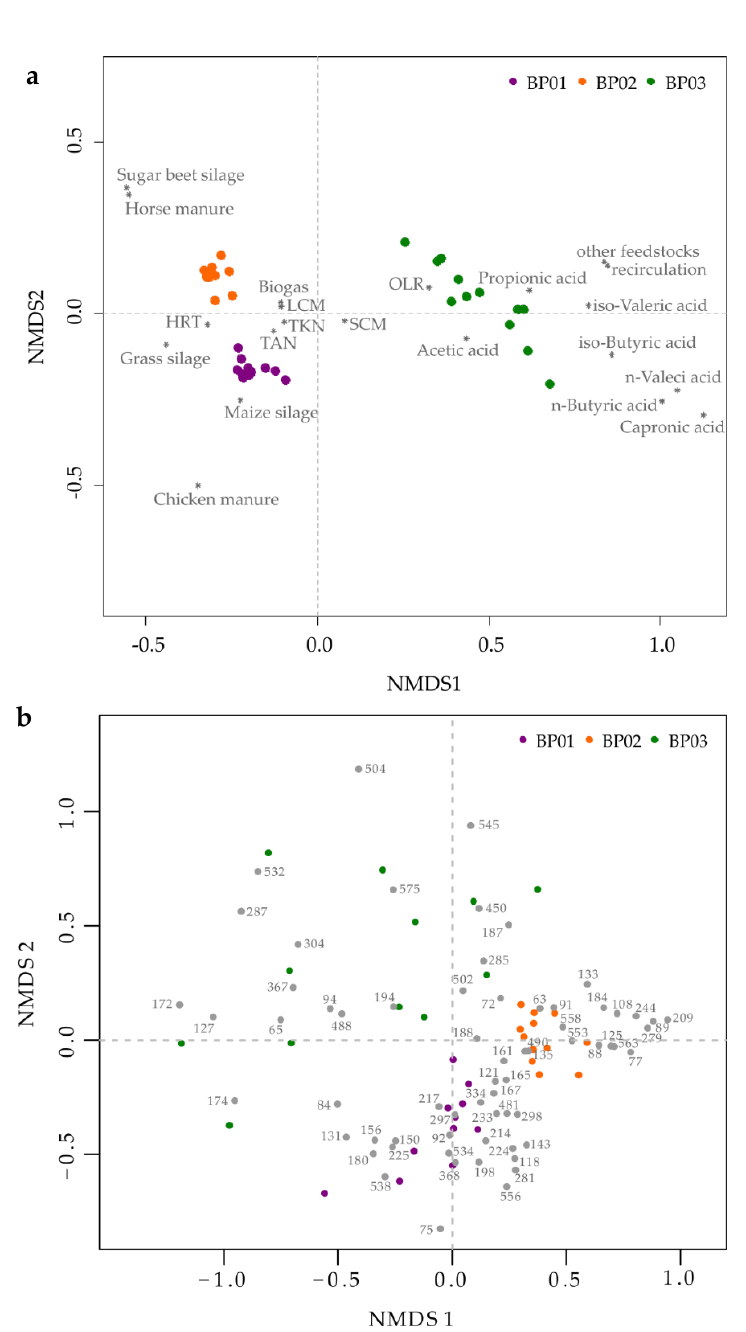
Figure 3. Non-metric multidimensional scaling (NMDS) analysis based either on the prevalent process engineering and process chemical parameters ( a ) or the detected bacterial terminal restriction fragments (given in gray dots with numbers) ( b ) of the three analyzed manure-based small biogas plants. Each colored dot symbolizes one sampling point of the respective biogas plant. Marked with a star ( ∗ ) are abiotic parameters with p = 0.001. OLR = organic loading rate, HRT = hydraulic retention time, TAN = total ammonium nitrogen, TKN = total Kjeldahl nitrogen, LCM = liquid cattle manure, SCM = solid cattle manure.